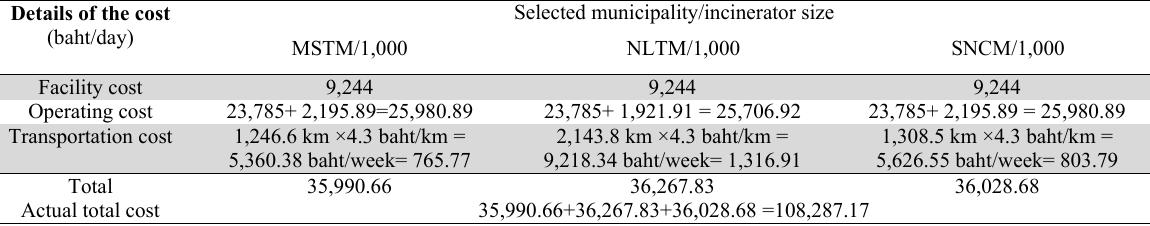
The actual costs of a case study Details of the cost